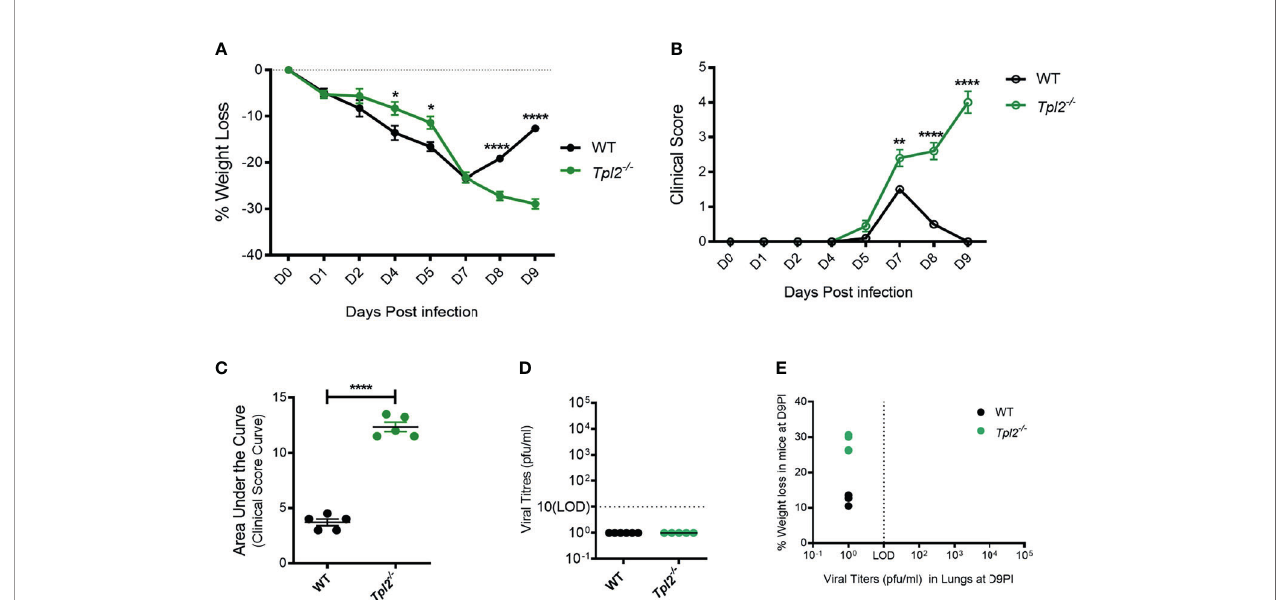
FIGURE 1 | Severe pathology in in fl uenza-infected Tpl2 -/- mice does not correlate with viral load. (A) Percent weight change of WT (n = 5) versus Tpl2 -/- (n = 5) mice 9 dpi with 10 4 pfu in fl uenza A virus strain x31. Data are representative of 5 experiments Unpaired student ’ s t -test; *p<0.05, **p<0.01, ****p<0.0001. (B) Progression of clinical symptoms including lethargy, piloerection, and hunching is shown throughout the course of infection. Data are representative of 5 experiments. Unpaired student ’ s t -test; *p<0.05, **p<0.01, ****p<0.0001. (C) Area under the curve statistics. Data are representative of 5 experiments, Area Under the Curve analysis was performed per genotype in Prism and then compared statistically by Unpaired student ’ s t -test; *p<0.05, **p<0.01, ****p<0.0001. (D) Lung viral titers (pfu/ml) were quantitated at 9 dpi. Baseline represents the limit of detection (LOD = 10 pfu/ml). Undetectable virus loads were assigned a value of 1. (E) Correlation of viral titers with weight loss at 9 dpi. Data are representative of 2 experiments. Two tailed Pearson ’ s Correlation test was performed *p<0.05,